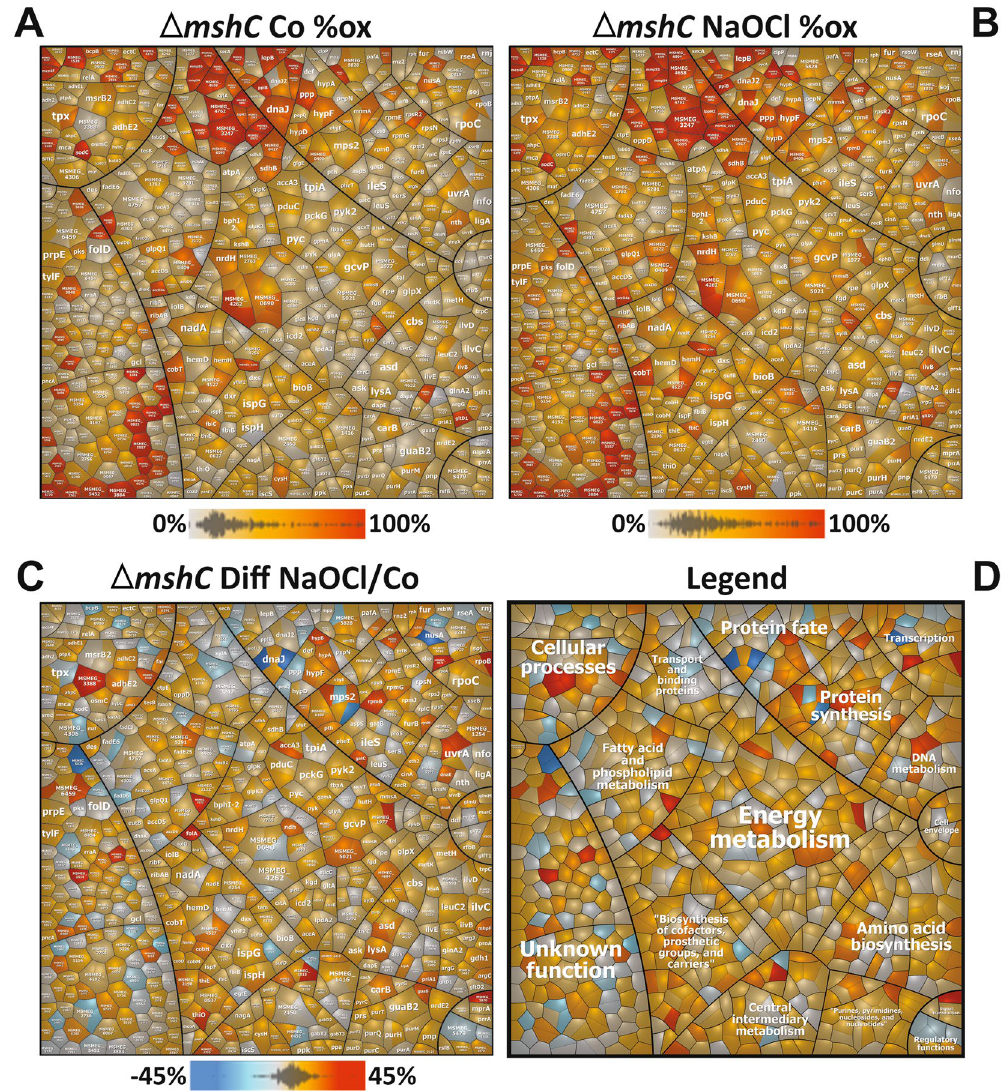
Figure 6. Voronoi redox treemaps show the percentages of thiol-oxidation levels of all Cys-peptides identified in the redox proteome of the M. smegmatis mshC mutant. The “ Voronoi redox treemaps ” show the percentages of thiol-oxidations of all 823 Cys-residues identified in the mshC mutant control ( A ) and 30 min after exposure to 0.5 mM NaOCl stress ( B ) The grey-yellow-red color gradient denotes 0–100% oxidation. The Voronoi redox treemap in ( C ) visualizes the percentages of oxidation changes under NaOCl stress using a blue-red color gradient ranging from − 60 to + 60% oxidation. The treemap in ( D ) is used as legend for the functional classification of the proteins displayed in ( C ). The treemaps are generated based on the OxICAT data presented in Table S4 using the Paver software (Decodon) and proteins were classified according to the M . smegmatis TIGRfam